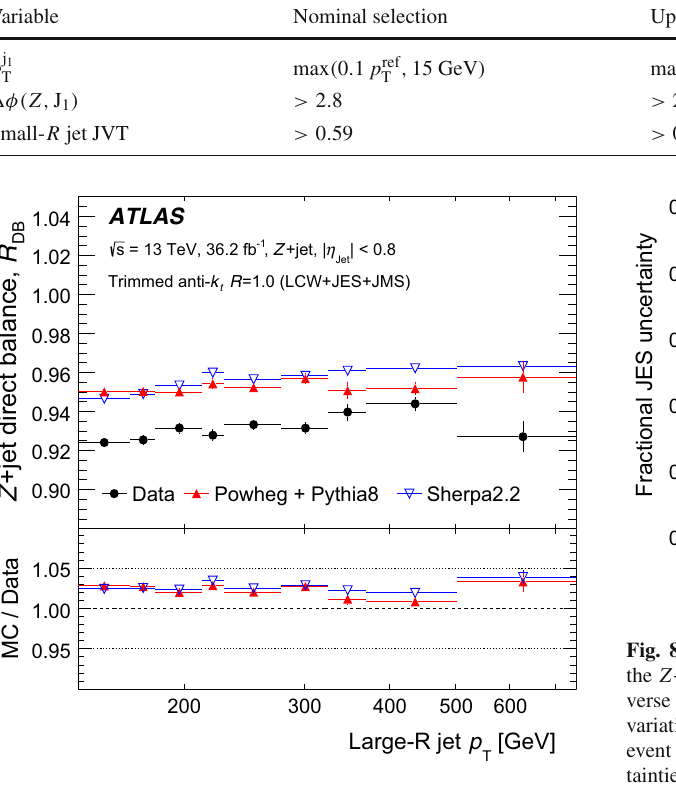
Fig. 7 The momentum balance R DB as a function of the large- R jet transverse momentum p T in Z +jet events for the combined e + e − and μ + μ − channels. Only statistical uncertainties are shown. For each p ref bin, the measured R DB is plotted against the average jet p T of the bin. Thehorizontalerrorbarsgiveanindicationofthewidthoftheassociated p ref bin T